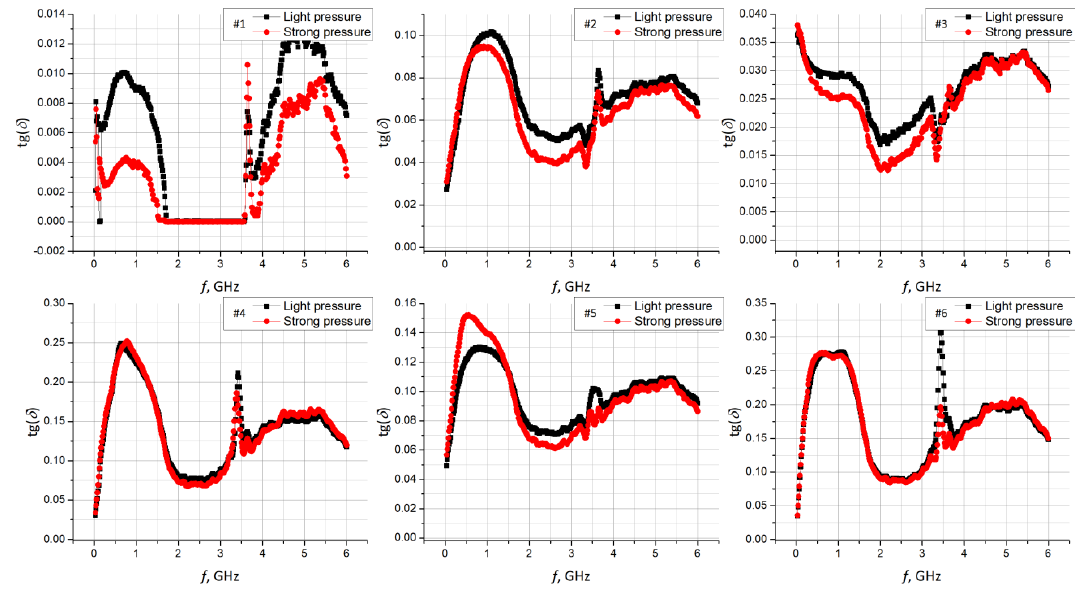
Figure 9. Comparison of tg δ for light and strong pressure on substrate samples. Table 5. Pearson ’ s coefficient from measurements for light and strong pressure on substrate sam- ples.